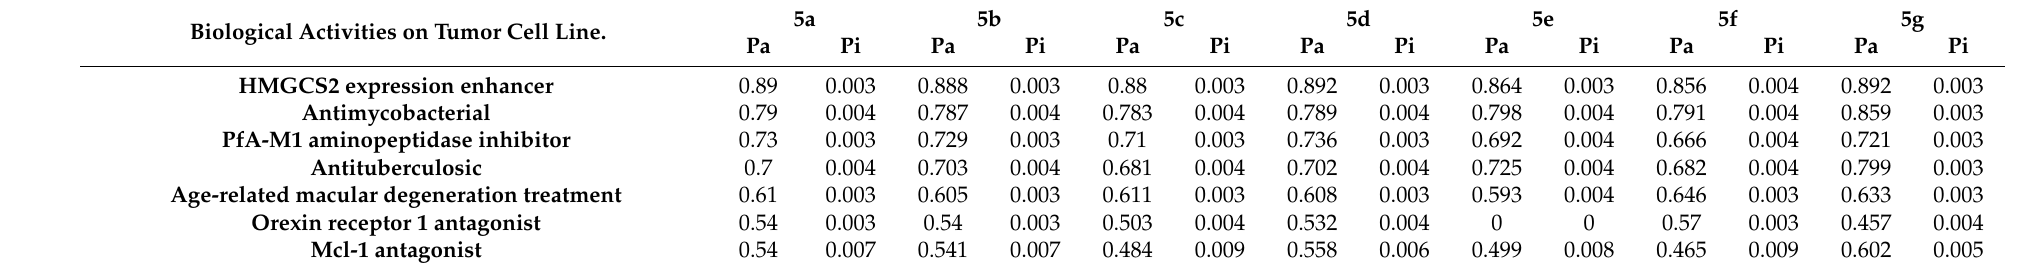
Table 4. The predicted activities of the SBs 5a–g on tumor cell lines using PASS at Pa > Pi. Biological Activities on Tumor Cell Line.